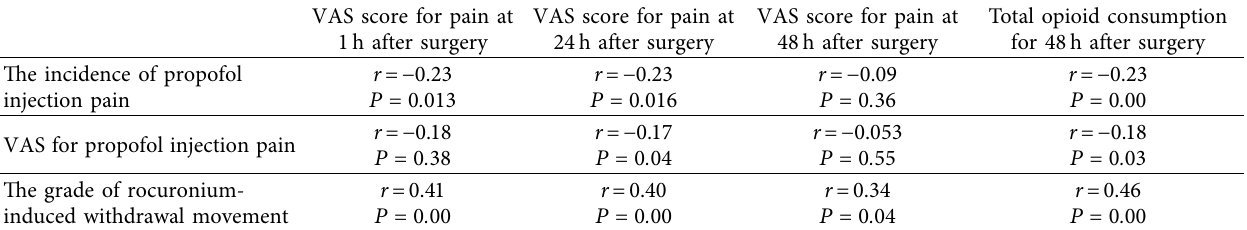
Table 4: The correlations between propofol injection pain, the grade of rocuronium-induced withdrawal movement, and pain outcomes.